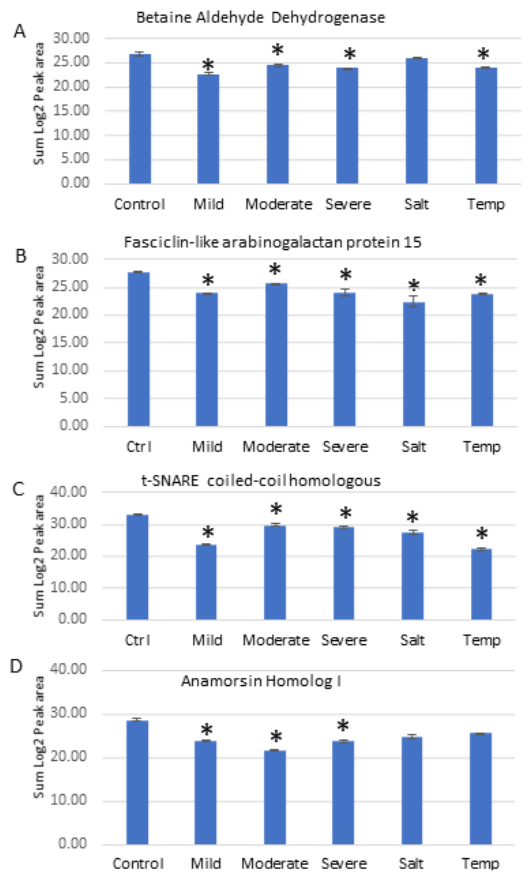
Figure 6. PRM validation of four proteins changed in abundance in response to abiotic stresses in Nipponbare plants. ( A ) = Betaine aldehyde dehydrogenase, ( B ) = Fasciclin-like arabinogalactan protein 15, ( C ) = t-SNARE coiled-coil homologous protein, ( D ) = Anamorsin homolog 1. Bars illustrate the relative abundance of proteins under control conditions, followed by mild, moderate and severe drought stresses, salt stress and temperature stress treatments. Y -axis indicates summed log2 peak area, which illustrates relative abundance, error bars indicate standard deviation. An asterisk (*) indicates a statistically significant difference between the control and stress condition, according to a Student t -test ( p -value < 0.05).